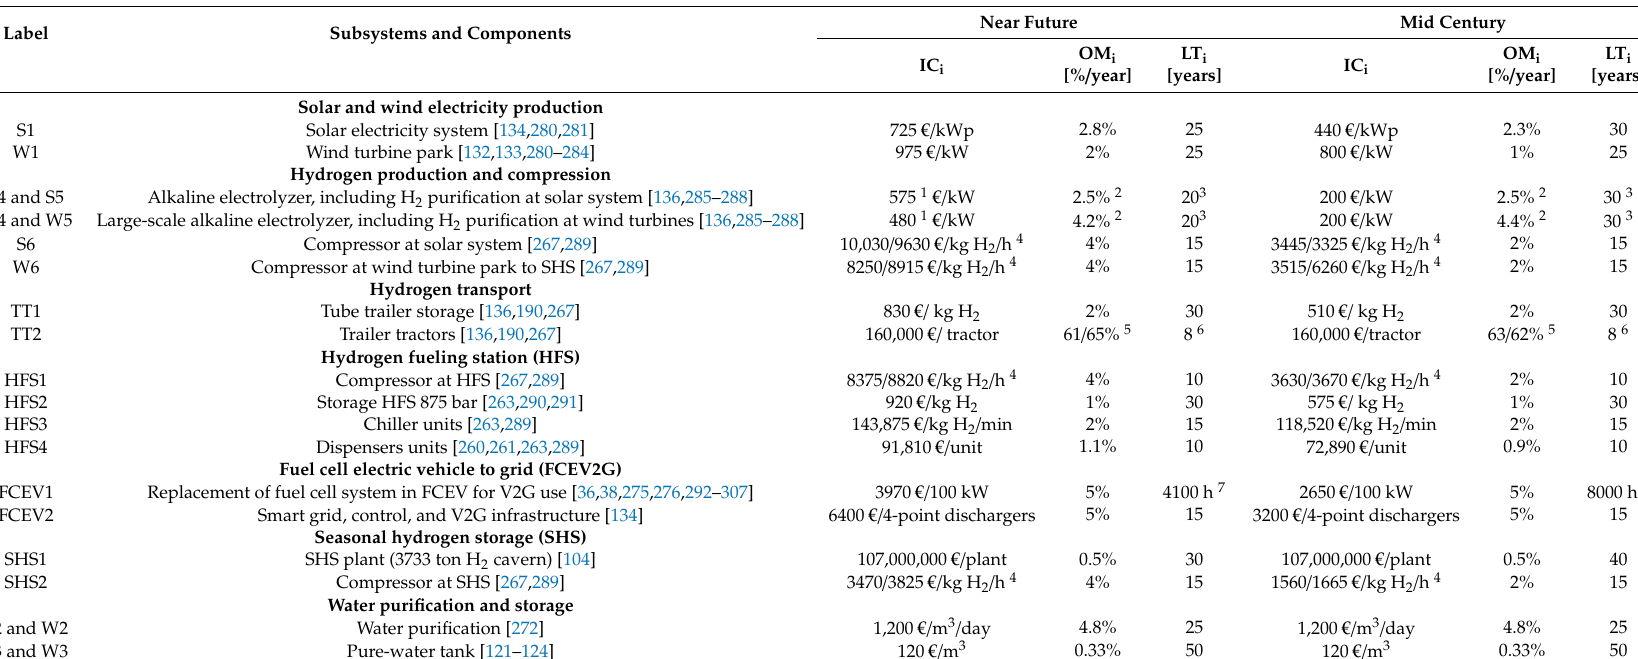
Table A3. Economic parameters of the smart city area components for the Near Future and the Mid Century scenario. IC i = installed capital cost; OM i = annual operational and maintenance cost expressed as an annual percentage of the installed investment cost; LT =